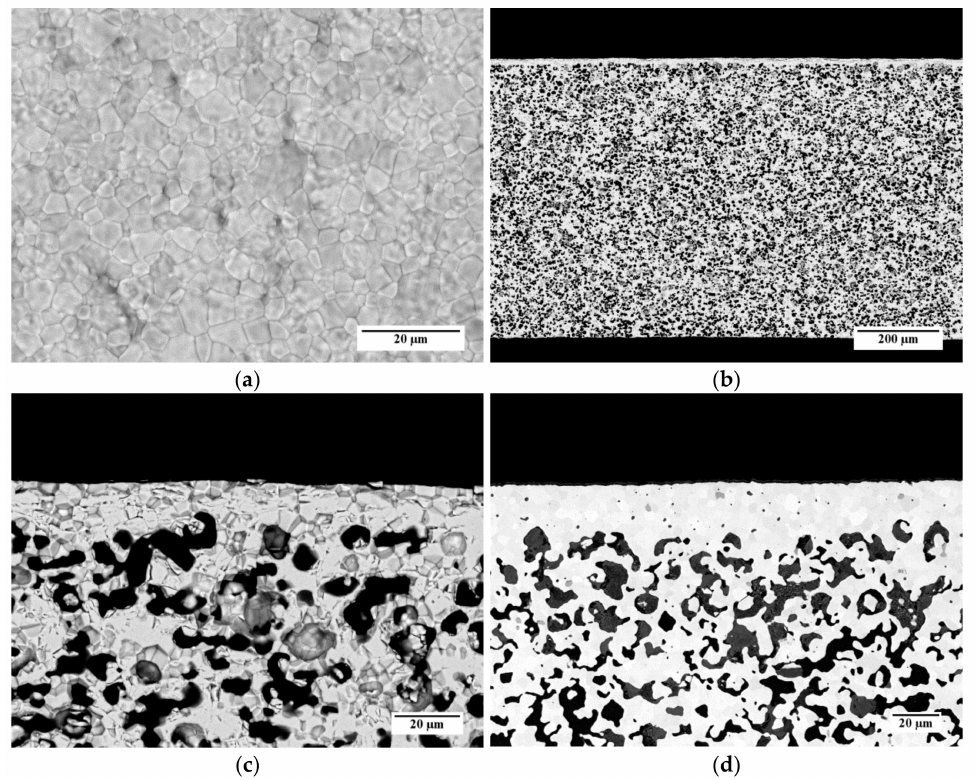
Figure 11. SEM micrographs of a membrane obtained using powder D from slurry 3 and sintered by TT3 : ( a ) Aspect of the membrane layer surface; ( b ) Cross-section; ( c ) Detail of the cross-section; ( d ) Detail of the cross-section of a membrane realized by the reference powder and